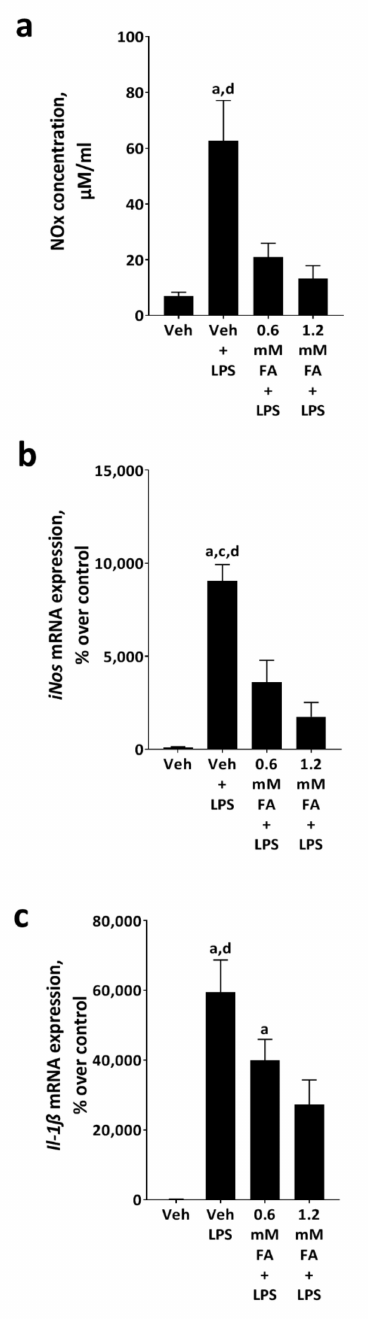
Figure 4. Effect of a 0.6 and 1.2 mM linolenic and linoleic acid mix, respectively, on the LPS-induced activation of J774A.1 cells. ( a ) NOx concentration in cell culture medium and mRNA expression of ( b ) inducible nitric oxide synthase ( iNos ) as well as ( c ) interleukin 1 β ( Il-1 β ) in cells. Cells were pre-incubated with a linolenic acid:linoleic acid mix (1:7.1) for 2 h followed by an 18 h incubation with 0 or 50 ng/mL LPS. Data are presented as means ± SEM, n = 3–5. Veh: vehicle; Veh + LPS: vehicle challenged with lipopolysaccharide; FA + LPS: fatty acids plus lipopolysaccharide. a p ≤ 0.05 compared to Veh. c p ≤ 0.05 compared to 0.6 mM FA + LPS. d p ≤ 0.05 compared to 1.2 mM FA + LPS. Data of NOx concentration were log-transformed before statistical